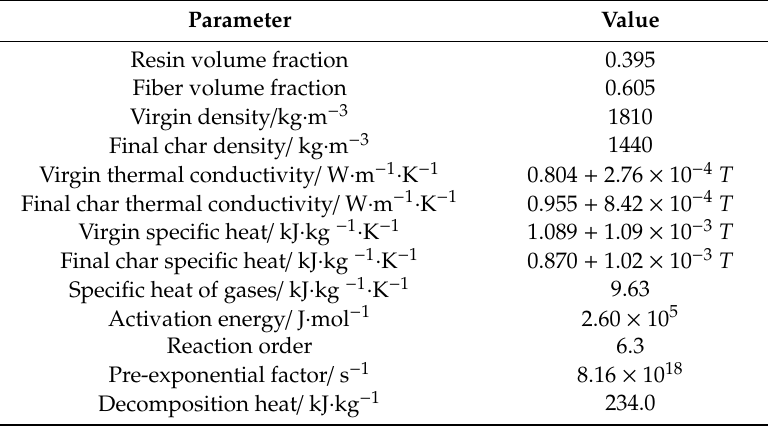
Table 1. Material performance for glass fiber/phenolic composite.